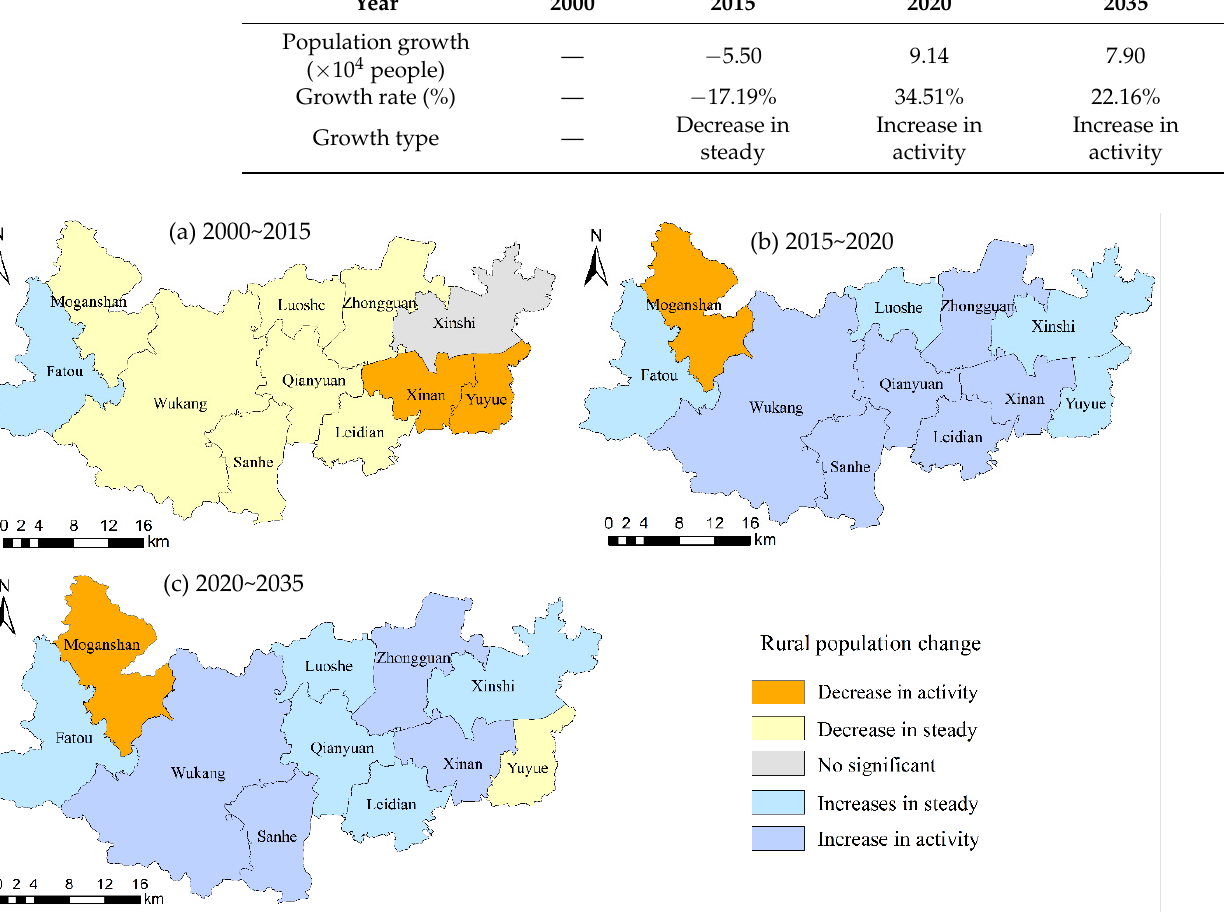
Figure 9. Rural population change during 2000–2035 at the town scale in Deqing.